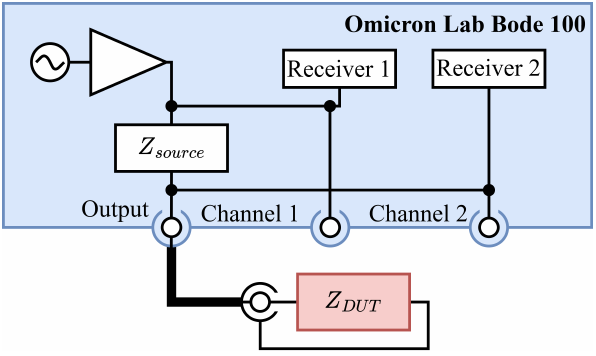
Figure 18. One-port measurement method